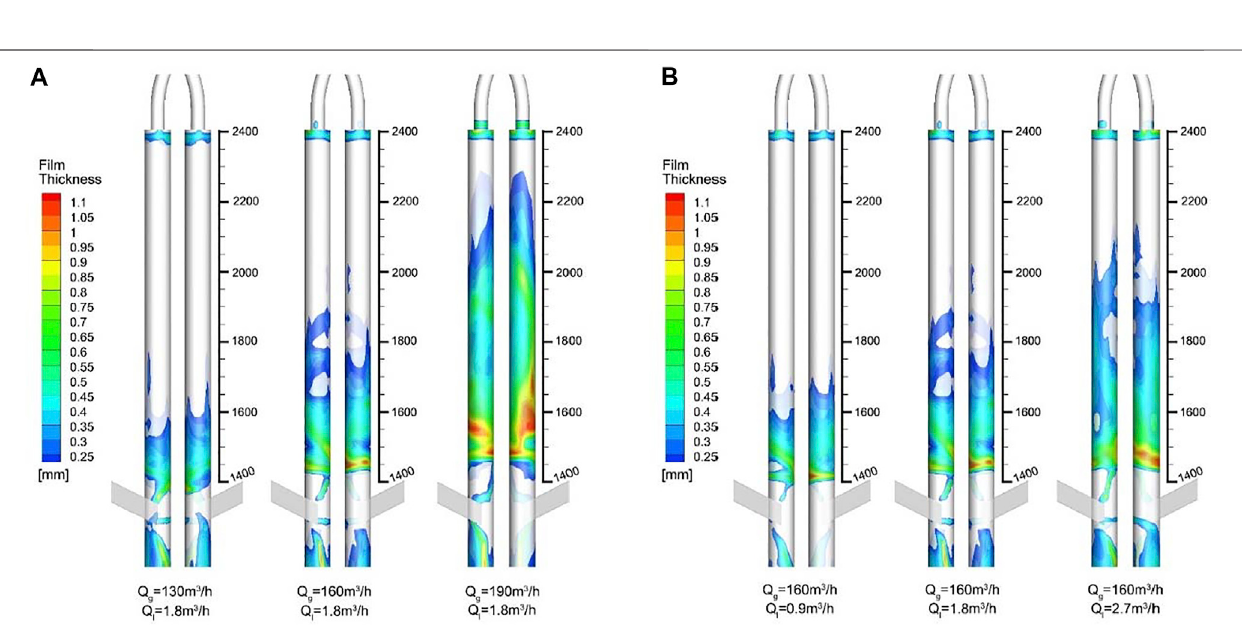
FIGURE 7 | Contours of USLF fi lm thickness distribution under different (A) gas fl owrates and (B) liquid fl owrates.